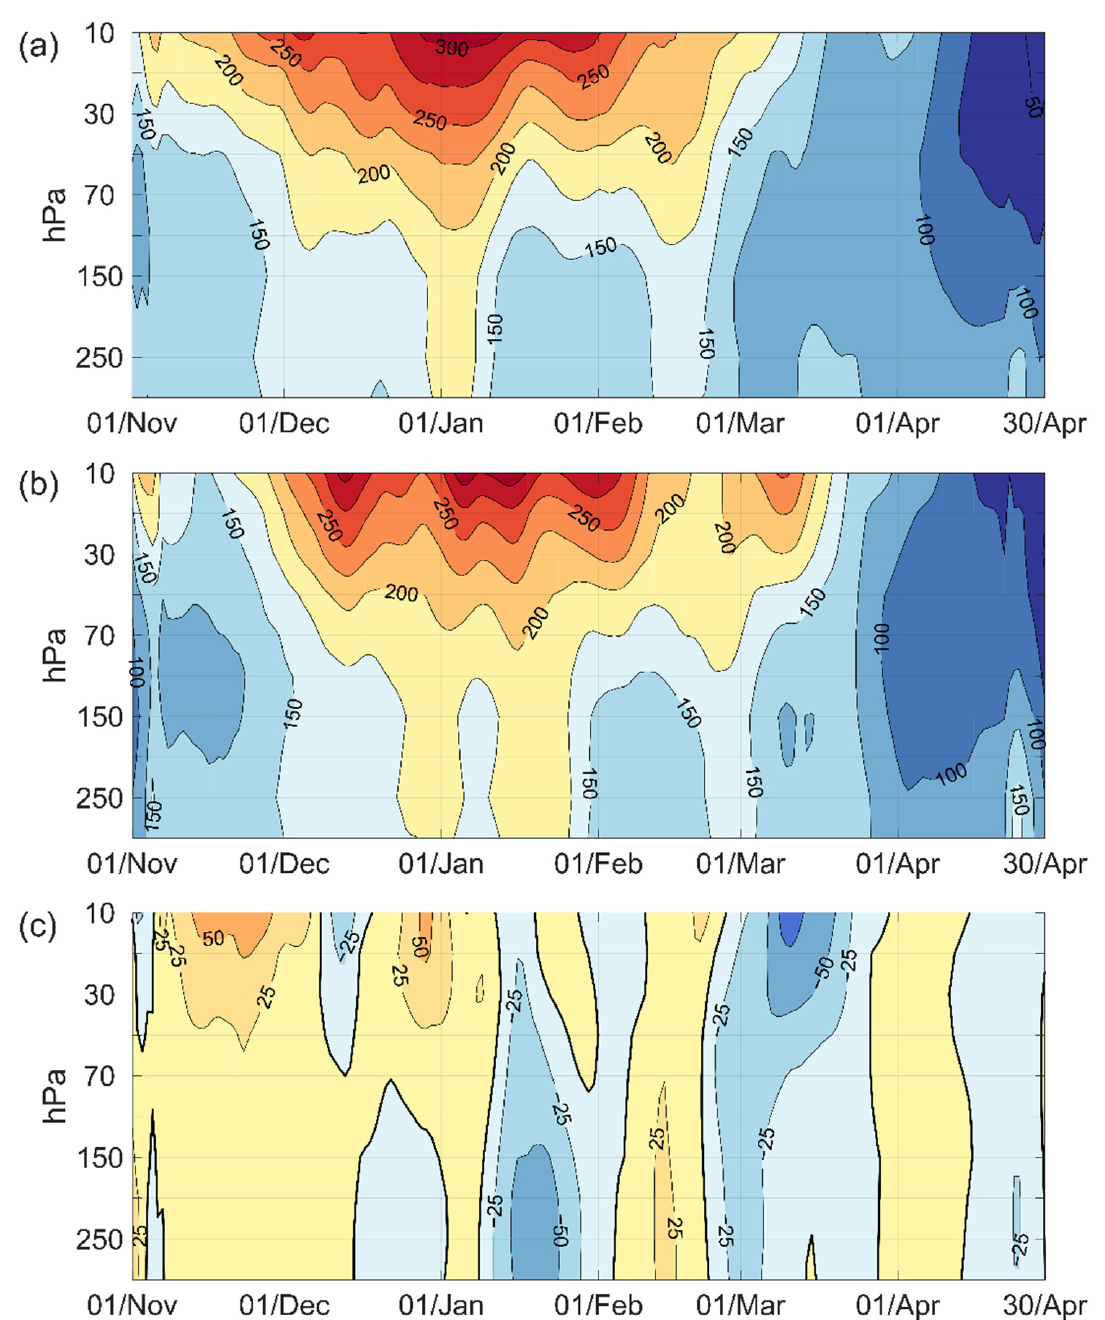
Figure 5. Composite vertical sections of amplitude of wave with zonal wave number 2 averaged between 50 and 70° N for ( a ) Eastern Pacific and ( b ) Central Pacific El Niño events and ( c ) difference between composites of EP and CP El Niño events. Values are smoothed with a 15-day running mean. Contour interval is 25 gpm. Black bold line indicates zero isoline.